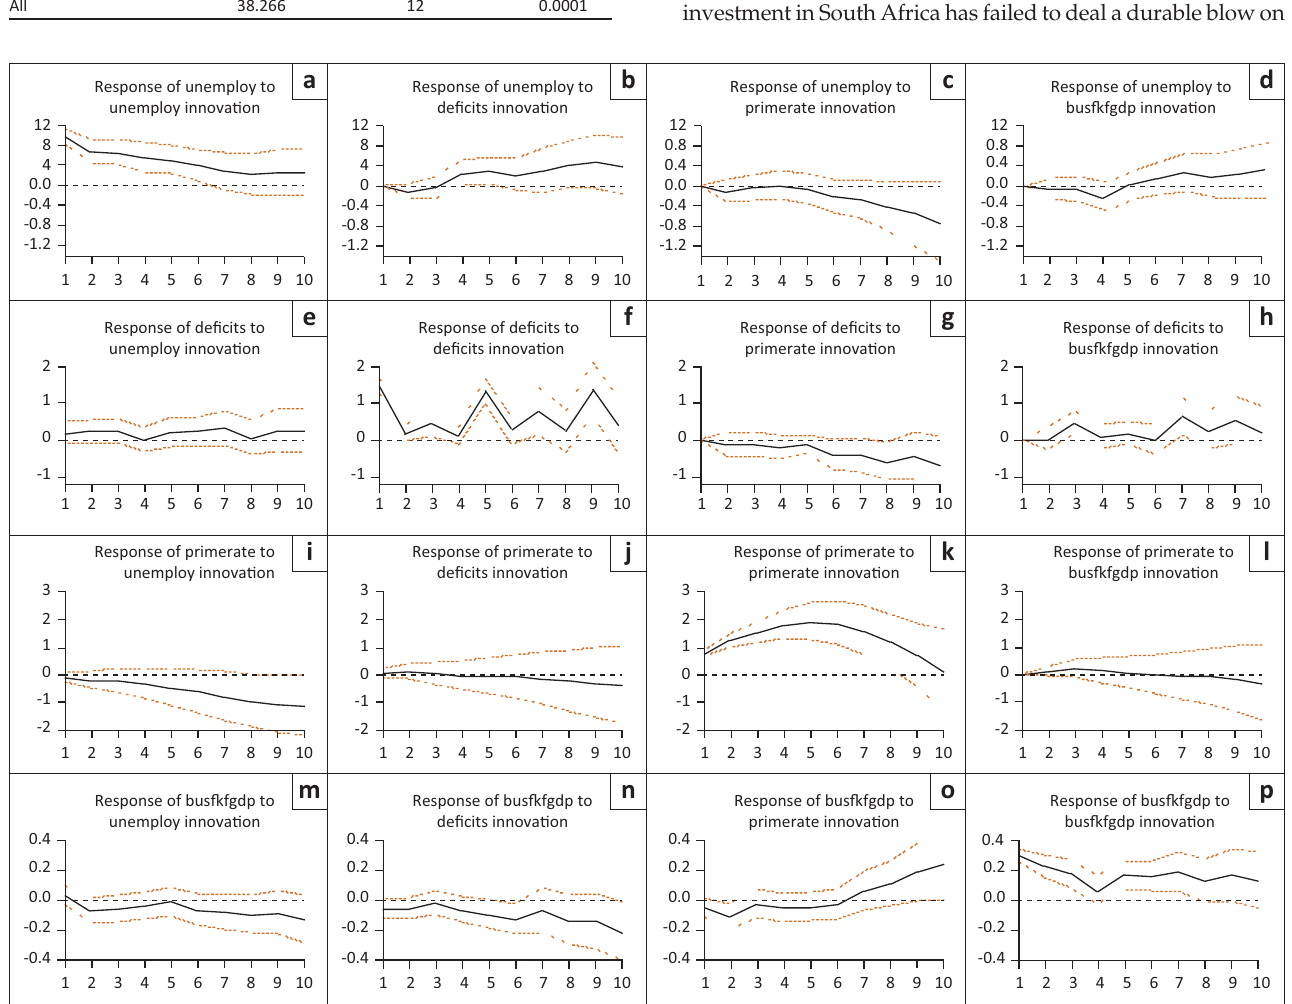
FIGURE 2: Impulse response analysis (a–p).